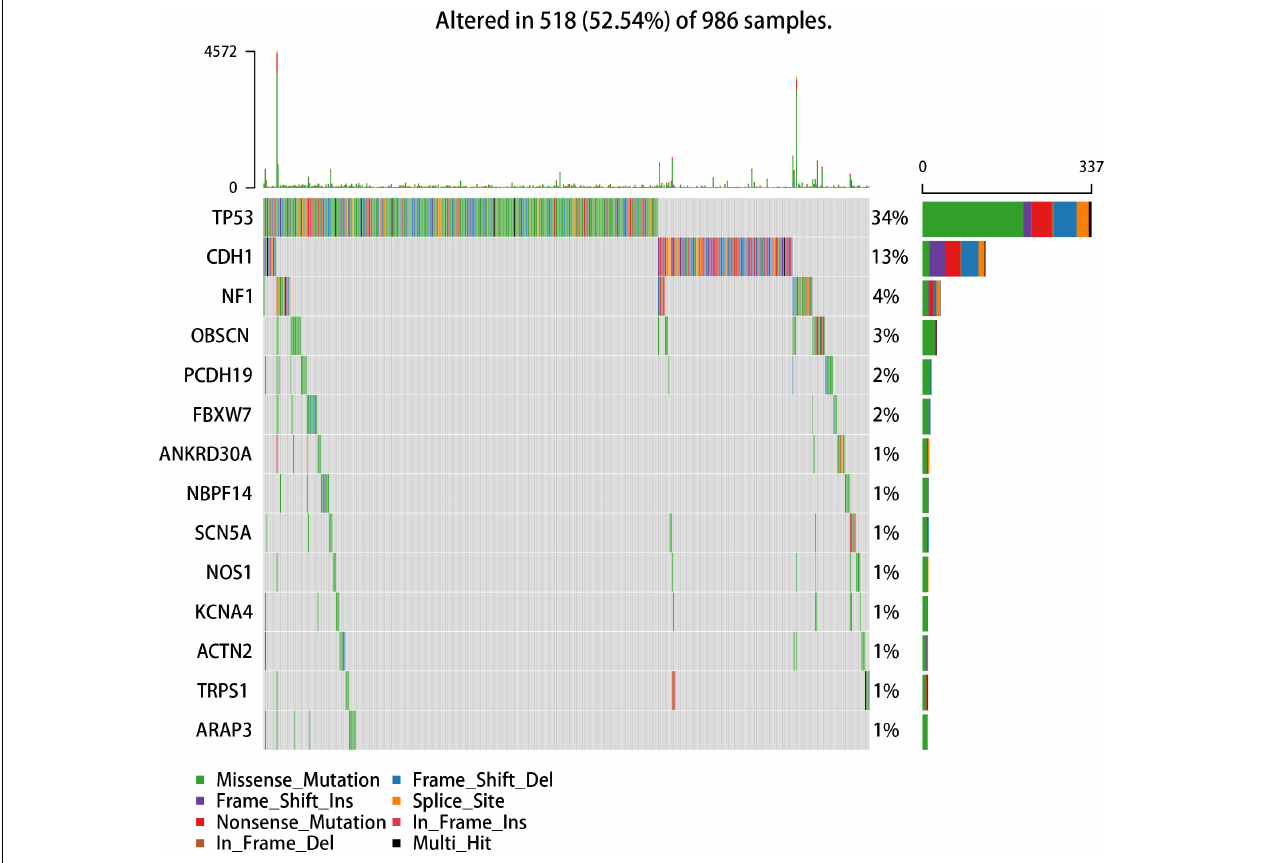
FIGURE 2 | Waterfall plot of mutation genes that drive immune cells in the GDC TCGA breast cancer